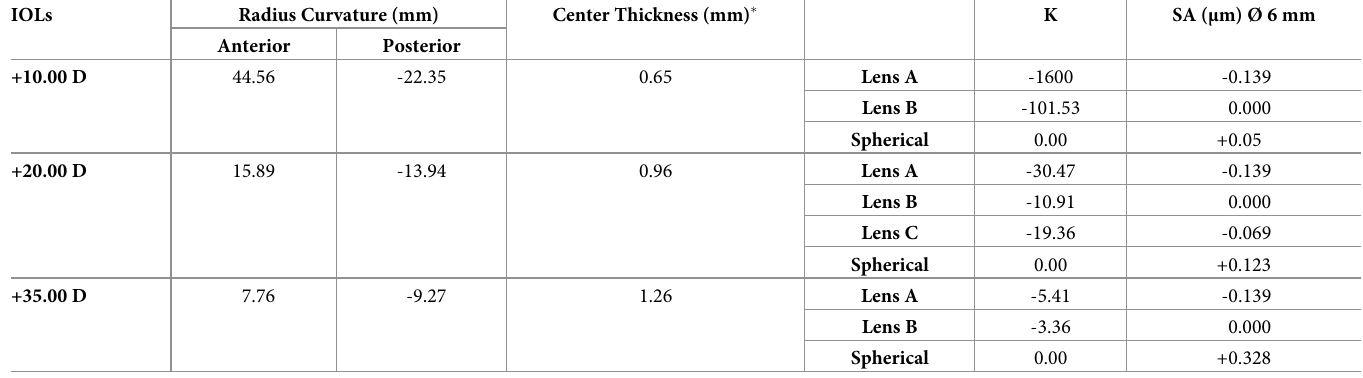
Table 2. Parameters of IOL lenses used in the simulations and experiments. K represents the conic constant values and SA represents the spherical aberration of IOL for 6.00 mm pupil diameter.